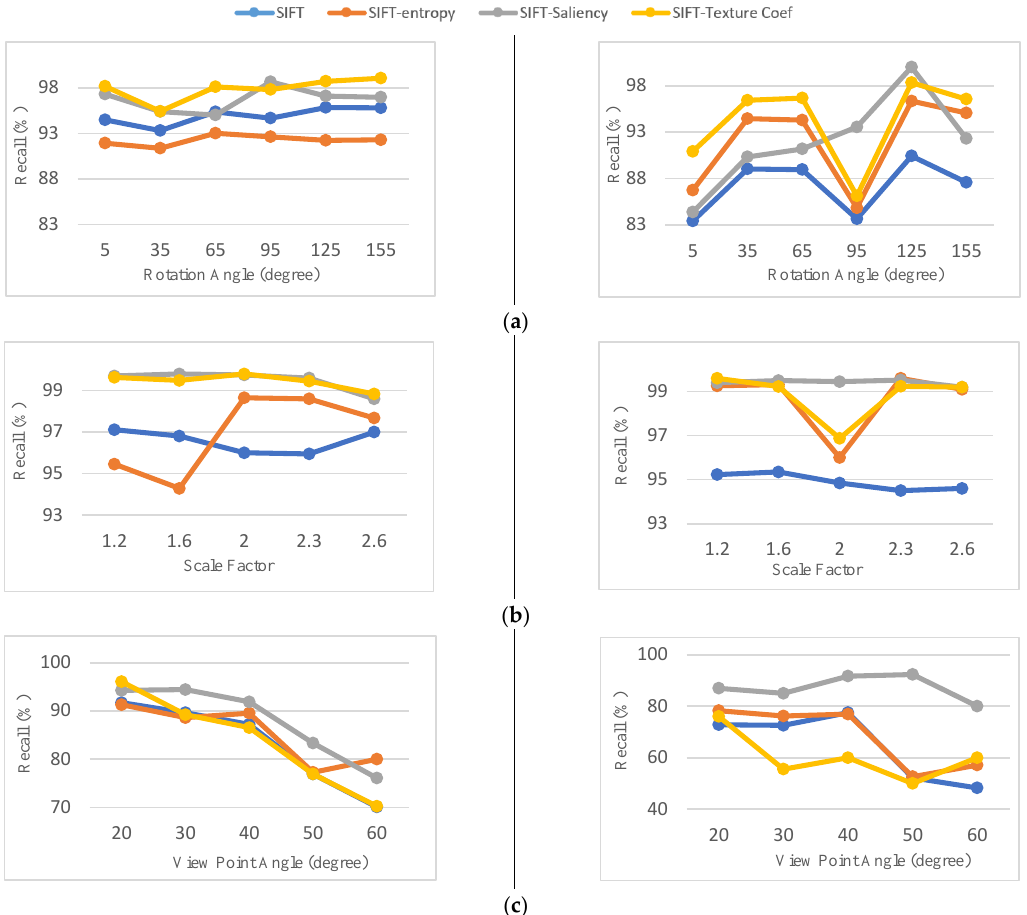
Figure 9. Recall results for the synthetic image pair of S1 (left column) and S2 (right column). ( a ) Rotation, ( b )scale, ( c ) viewpoint change.